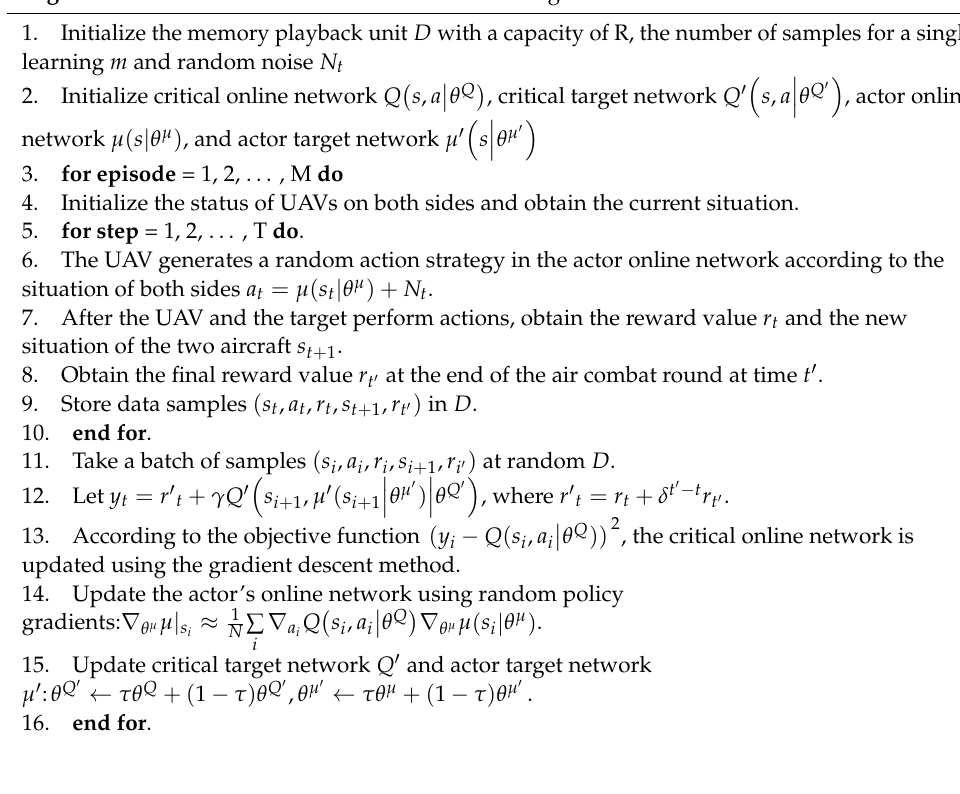
Algorithm 1 : FRV-DDPG UAV air combat decision